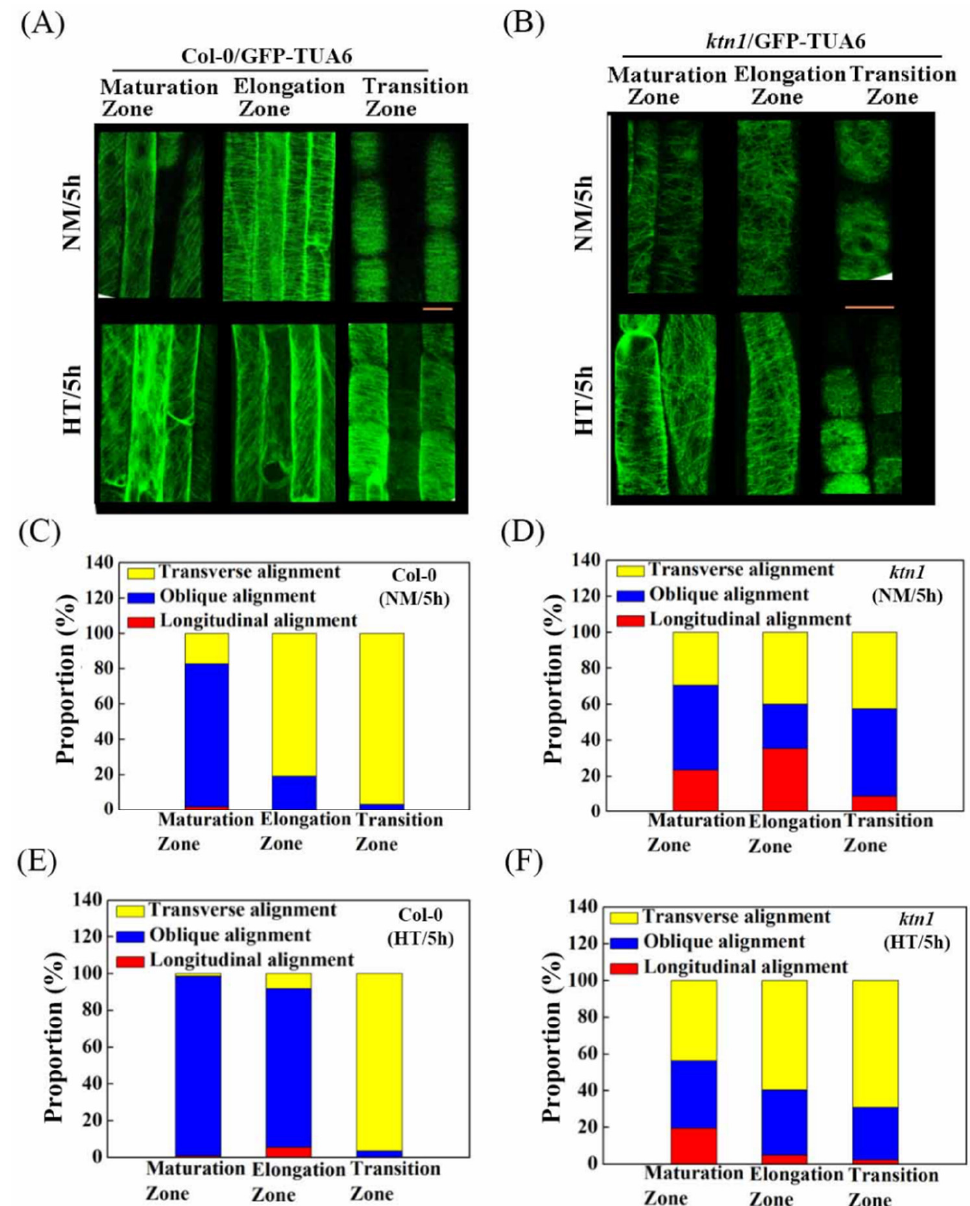
Figure 3. Cortical microtubule arrays in the root cells of WT Col-0 but not the ktn1 mutant are reoriented after hydrostimulation treatment. Cortical microtubules were observed in cortical cells of root maturation (left), elongation (middle), and transition (right) zones from WT ( A ) and the ktn1 mutant ( B ) under control and hydrostimulation treatment (HT). Quantification of root cortical cell microtubules’ orientation in WT under control ( C ) and hydrostimulation treatment (HT) ( E ) for 5 h ( n > 30 cells of each line). Quantification of root cortical cell microtubule orientation in the ktn1 mutant under control ( D ) and hydrostimulation treatment (HT) ( F ) for 5 h ( n ≥ 30 cells of each line). Scale bar = 10 µ m. Cortical microtubule orientation was measured by using ImageJ v.1.46 (National Institutes of Health, Bethesda, MD,